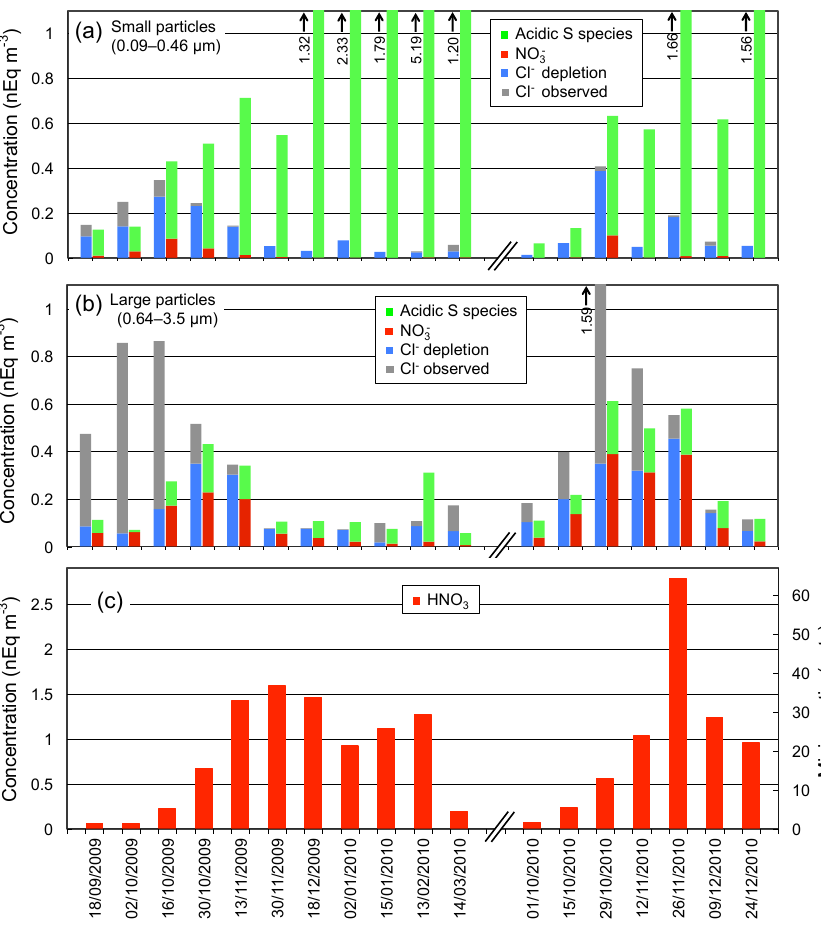
Figure 7. Acidic compounds and chloride depletion relative to sodium from October to December in 2009 and 2010. (a, b) Observed chloride (grey) and estimated loss of chloride (in blue, Eq. 2) vs. nitrate (in red) and acidic sulfur species (in green, see Sect. 3.1) in small (a) and large particles (b) . (c) HNO 3 sampled on denuder tubes over the same time period. All concentrations are here expressed in nanoequivalents per cubic meters STP (nEqm − 3 )